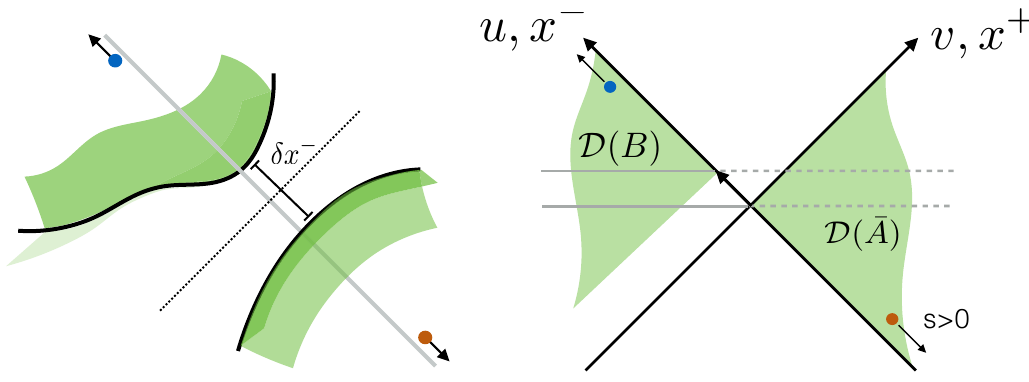
Figure 1 . Our setup involves two causally disconnected regions of Minkowski space, the domains of dependence of B and ¯ A (shaded green regions). These become close to null separated along a null line (gray curve in the left figure) along which we would like to prove the QNEC. The null separation along this line is the coordinate length δx − . We insert two operators (blue and red dots) in these respective regions in a lightcone limit close to the continuation of this null